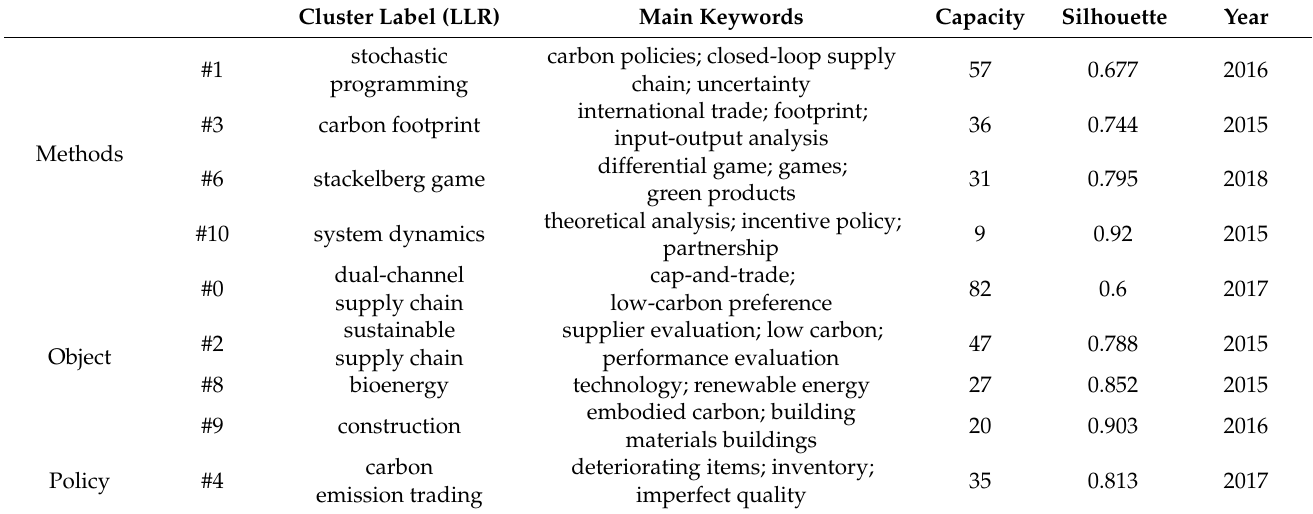
Table 6. Main clusters and their detailed